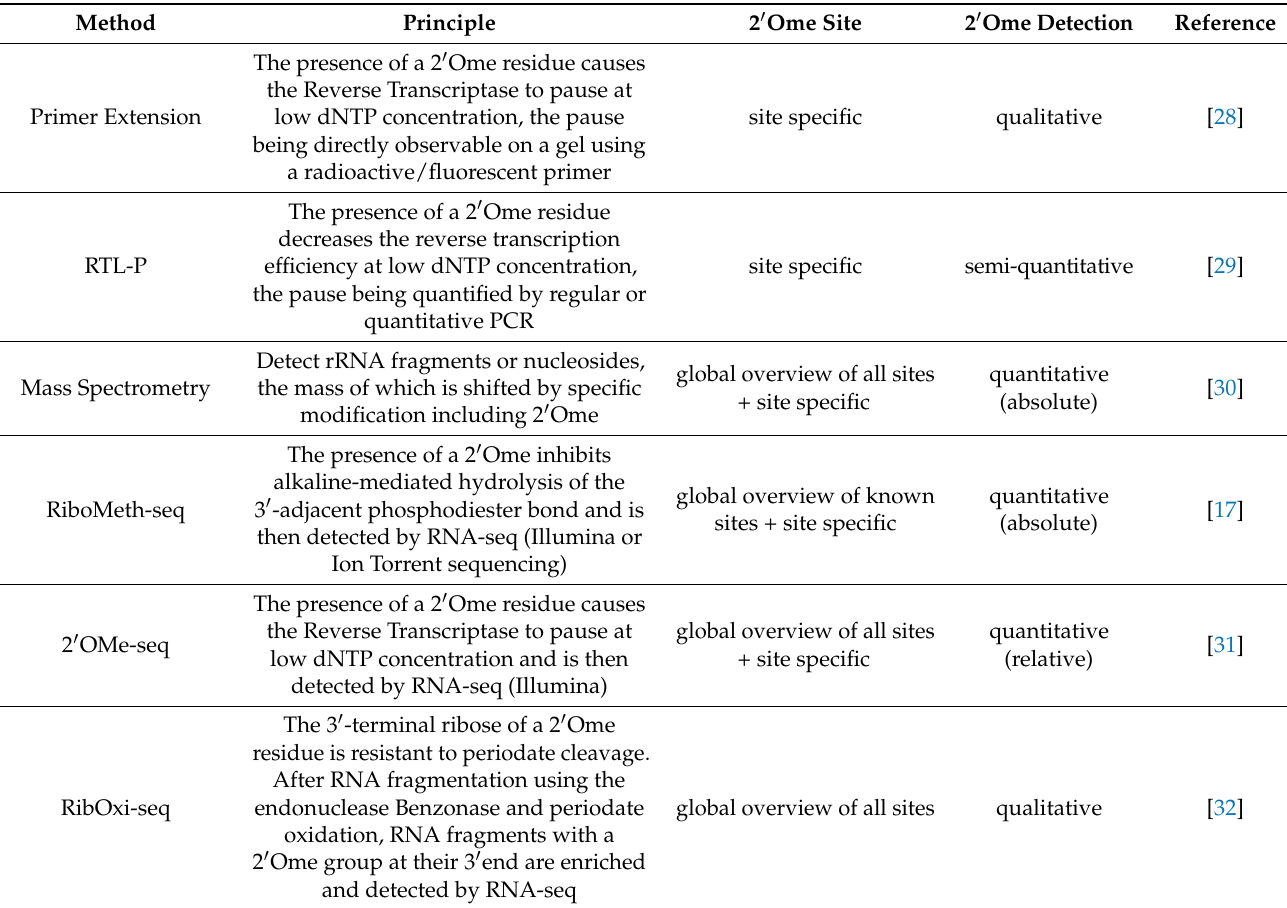
Table 1. Description of the different methods used to quantify and detect the 2 (cid:48) Ome.